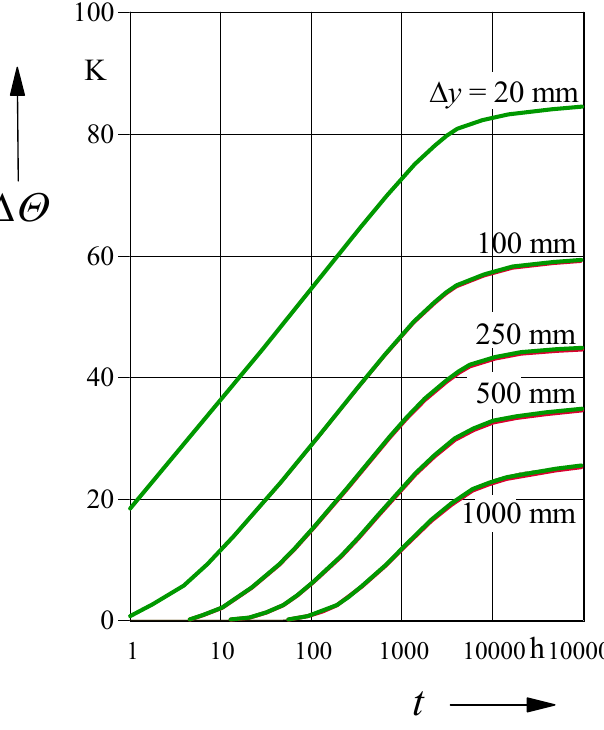
Figure 6. Thermal step responses (9) of a line ( z (cid:48) = − 30 . . . + 30 m) with point sources (green lines Δ l = 0.01 m), each with a loss step of W Δ l ( Δ W = 100 W/m) at t = 0, at a distance Δ y below the line (y = 2.0 m, at z (cid:48) = 0 m), compared with the step responses (10) of infinite line sources (red lines, mostly